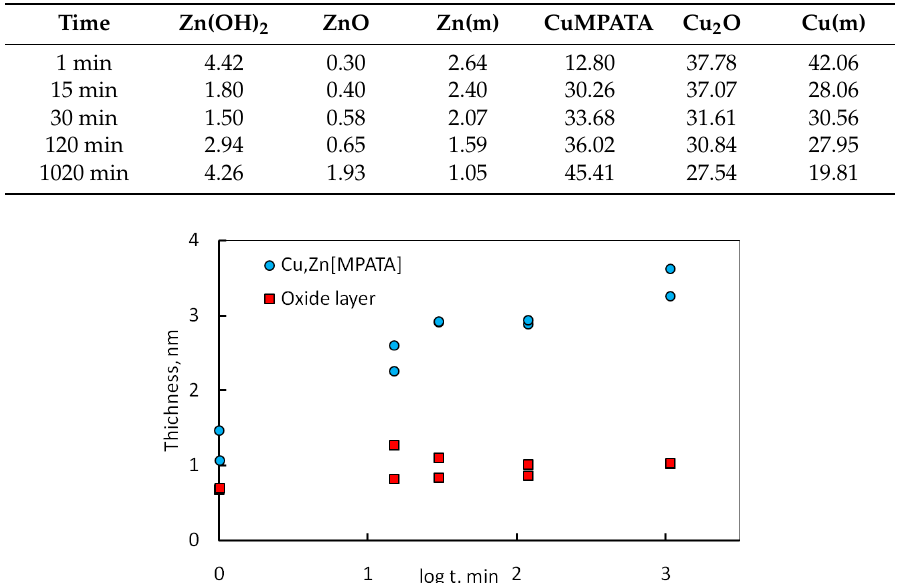
Table 1. Composition of Zn and Cu in surface layers (at %) after brass exposition in borate buffer solution (0.01 mM MPATA).